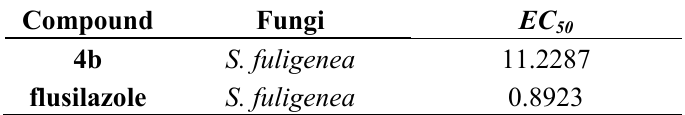
) ( μ g mL − 1 ) of the compounds 4b 50